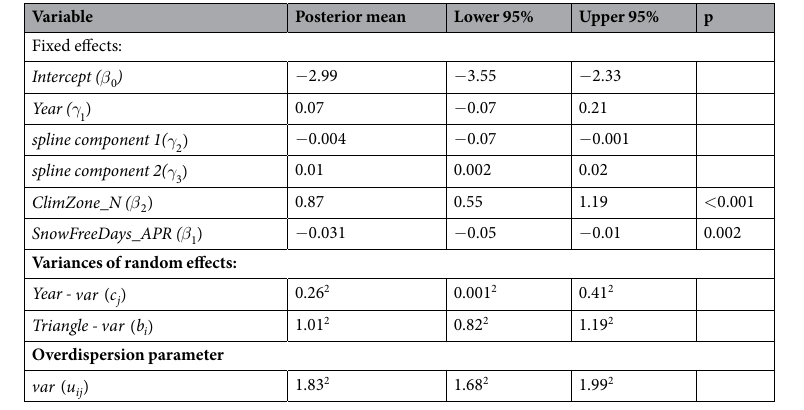
Table 2. The final model showing the effect of the strongest predictor, snow-free days in the preceding April, on willow grouse numbers.